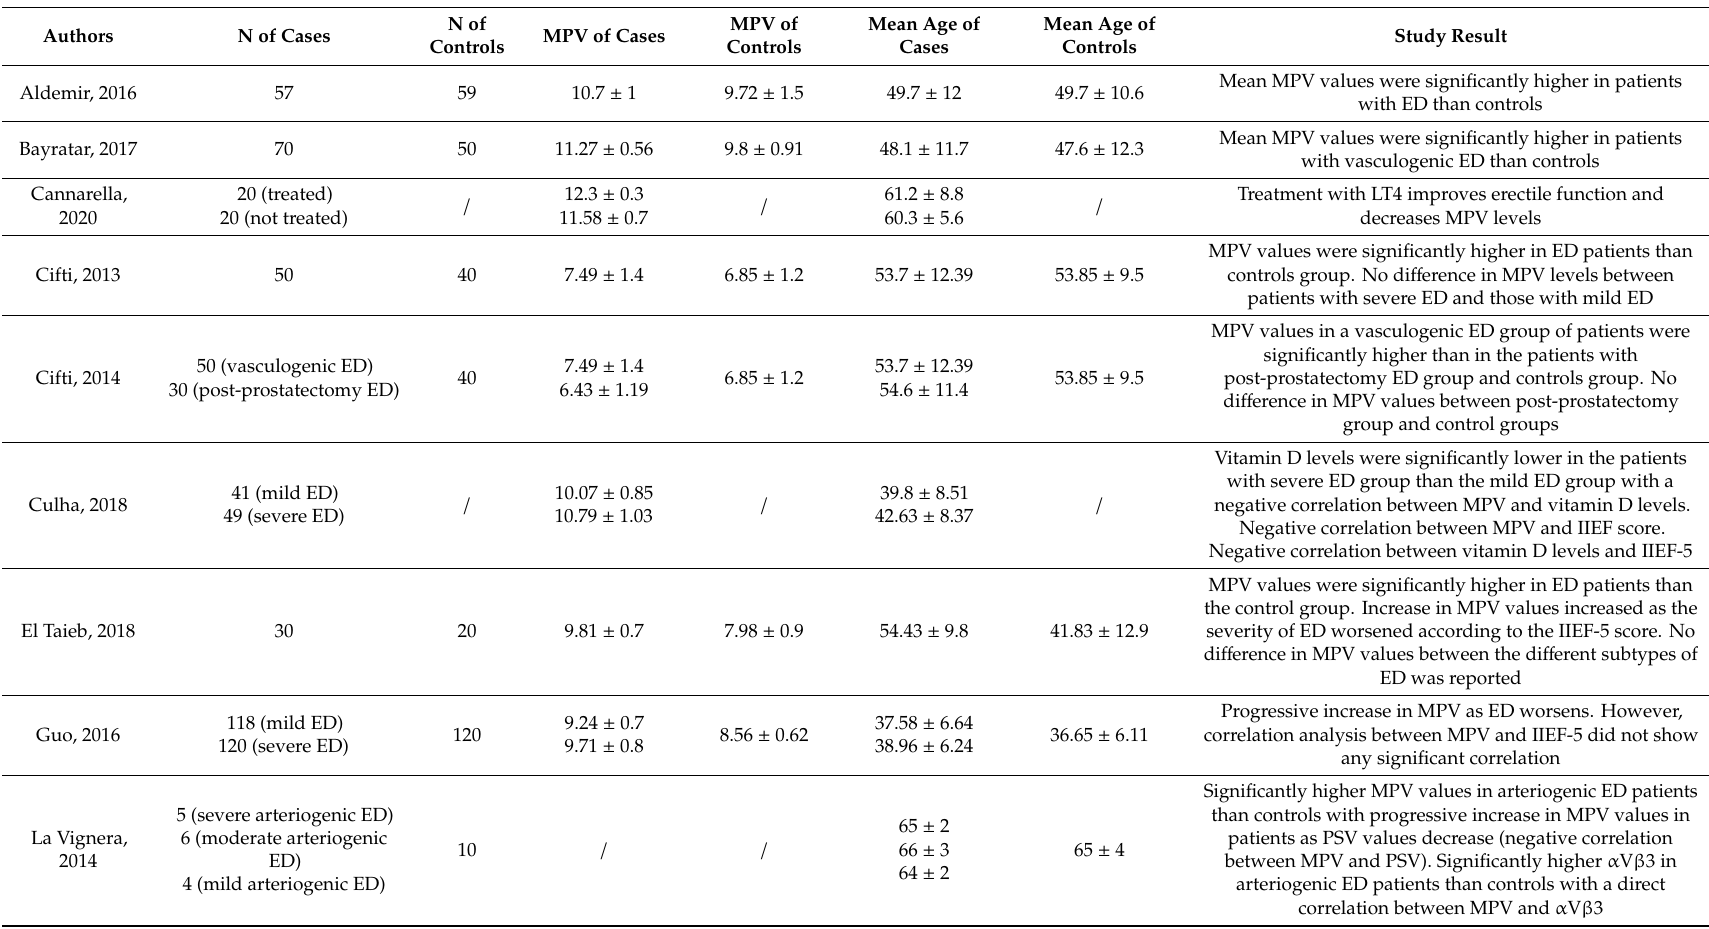
Table 1. Sample size, population characteristics, and results of studies evaluating the role of mean platelet volume (MPV) in patients with erectile dysfunction (ED)